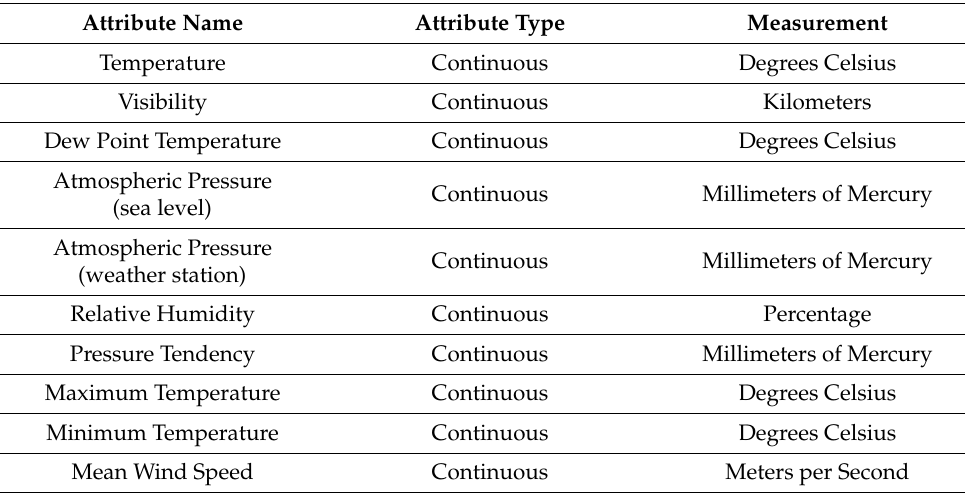
Table 3. Dataset